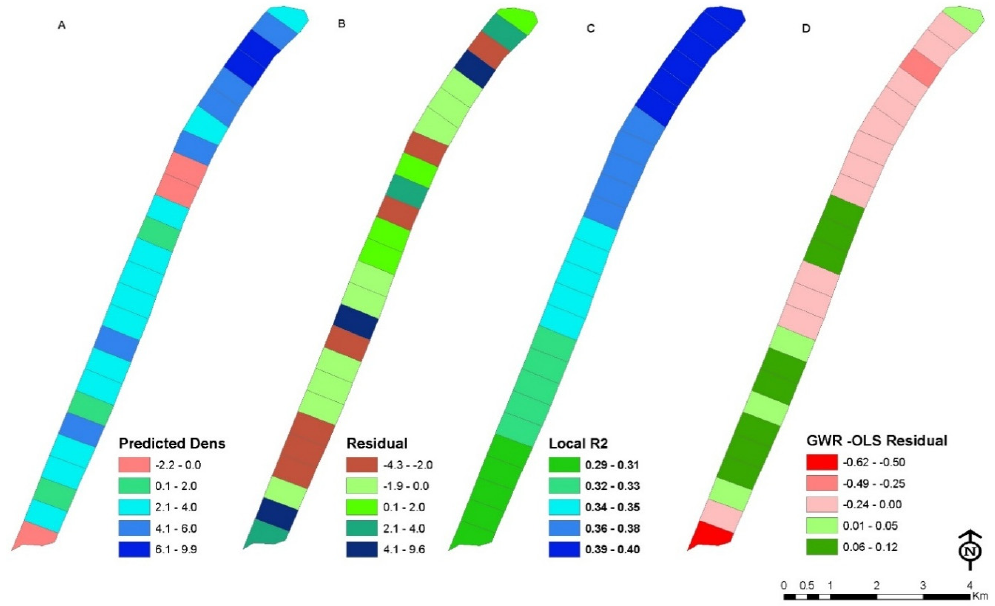
Figure 10. GWR regression analysis where ( A ) is the predicted number of fox den entrances, ( B ) is the distribution of residuals (predicted dens minus observed), ( C ) is the local R 2 values for each zone, and ( D ) is the difference between GWR residuals and OLS residuals.